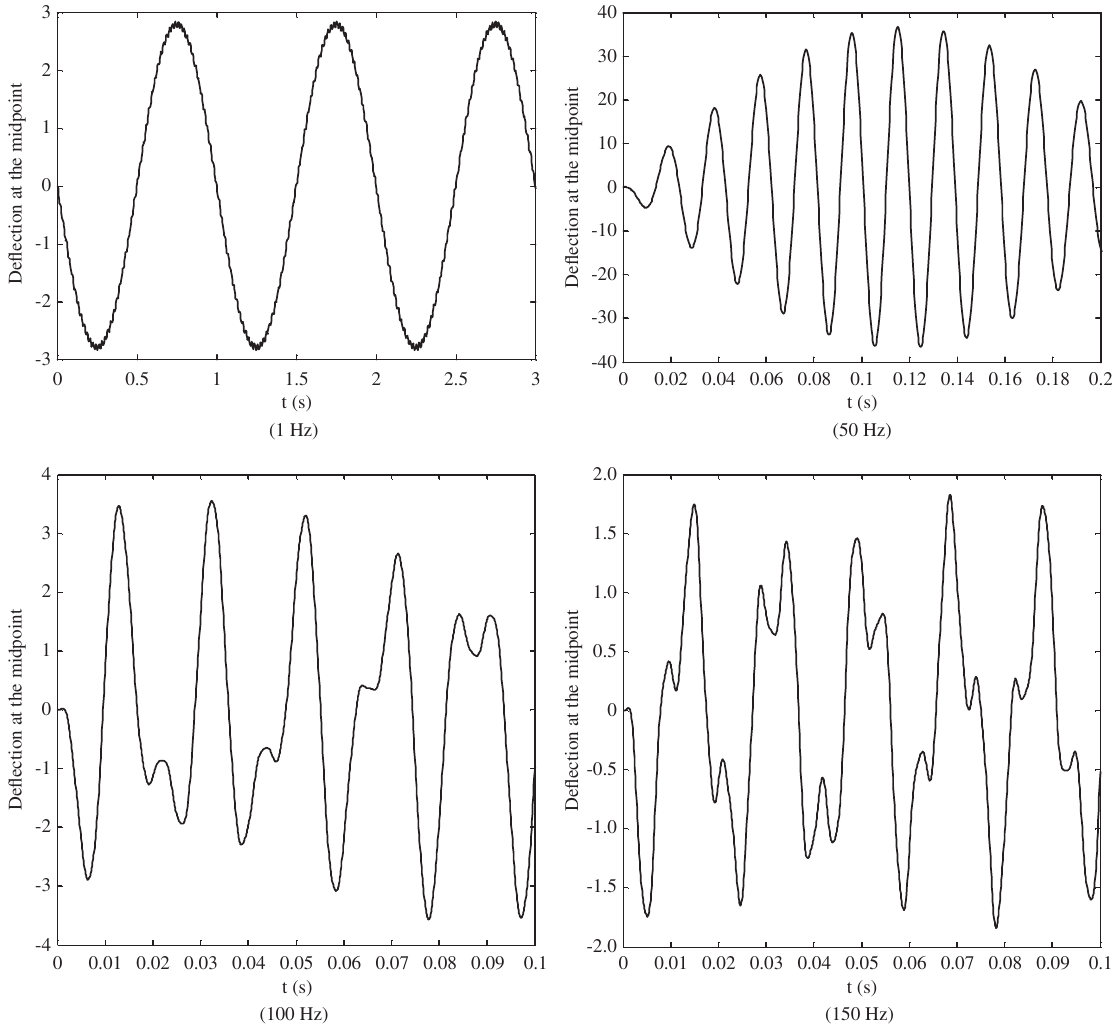
Figure 4 Forced vibration of cantilevered composite beam with delamination at interface 1 (frequency of exciting force: 1, 50, 100, and 150 Hz).